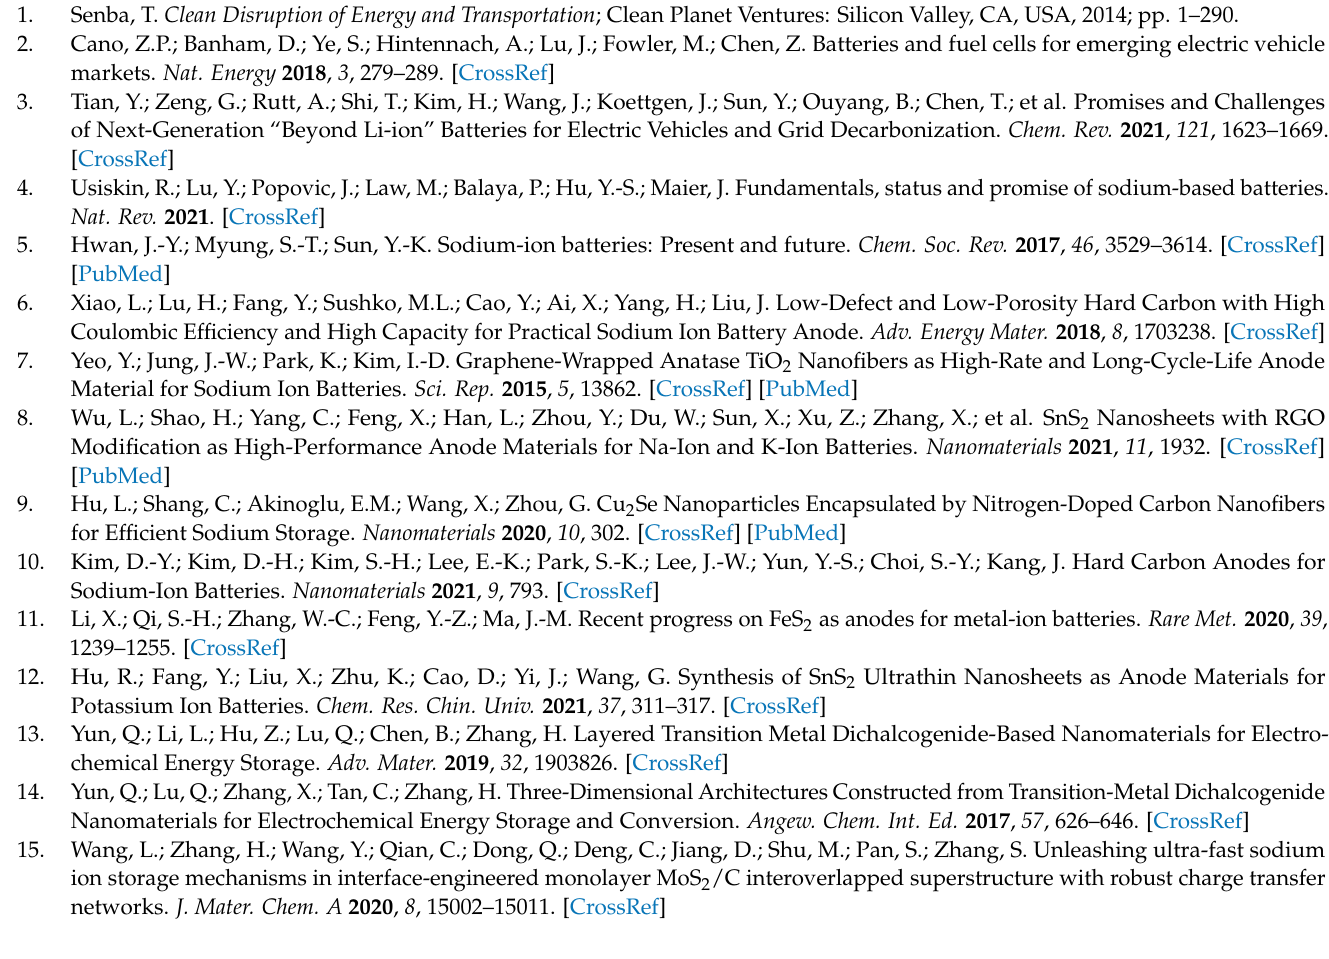
bonding), Figure S4: Charge–discharge curves of MoS2@CNFs at a current density of 100 mA g − 1, Figure S5: Lithium-ion battery performance of